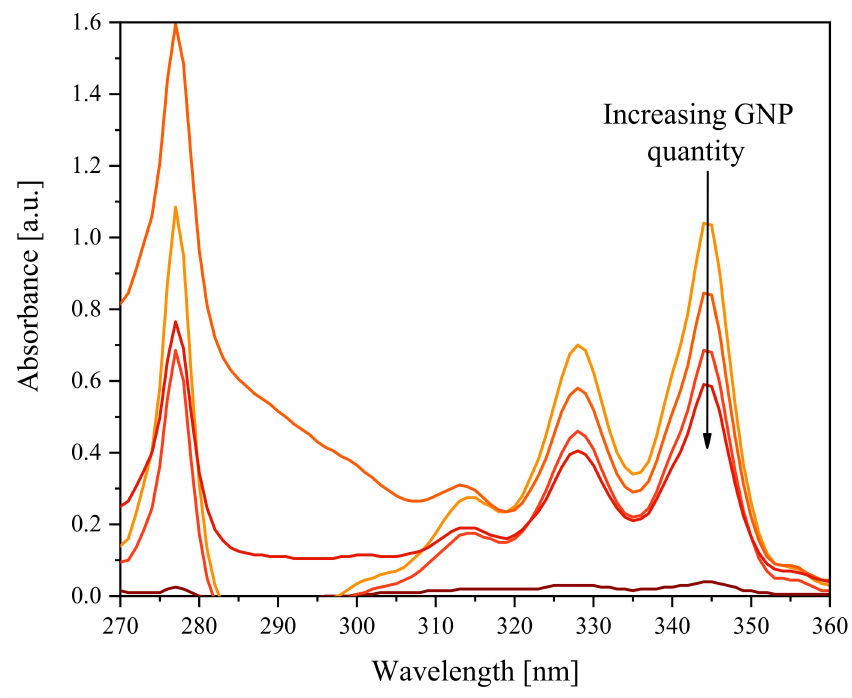
Figure 6. UV-Vis spectra of Pyr-PCL DMF solution surnatant with different amounts of GNP, after sonication and 7 days of sedimentation: neat, 0.5 mg, 1 mg, 2 mg, 5 mg from orange to brown.